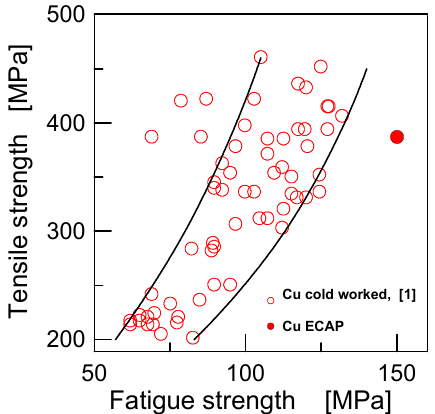
Figure 6: Comparison of S-N data for UFG and cold worked Cu. Figure 7: Relation of tensile and fatigue strength for fatigue limit based on 10 8 cycles for cold worked Cu [1] and UFG